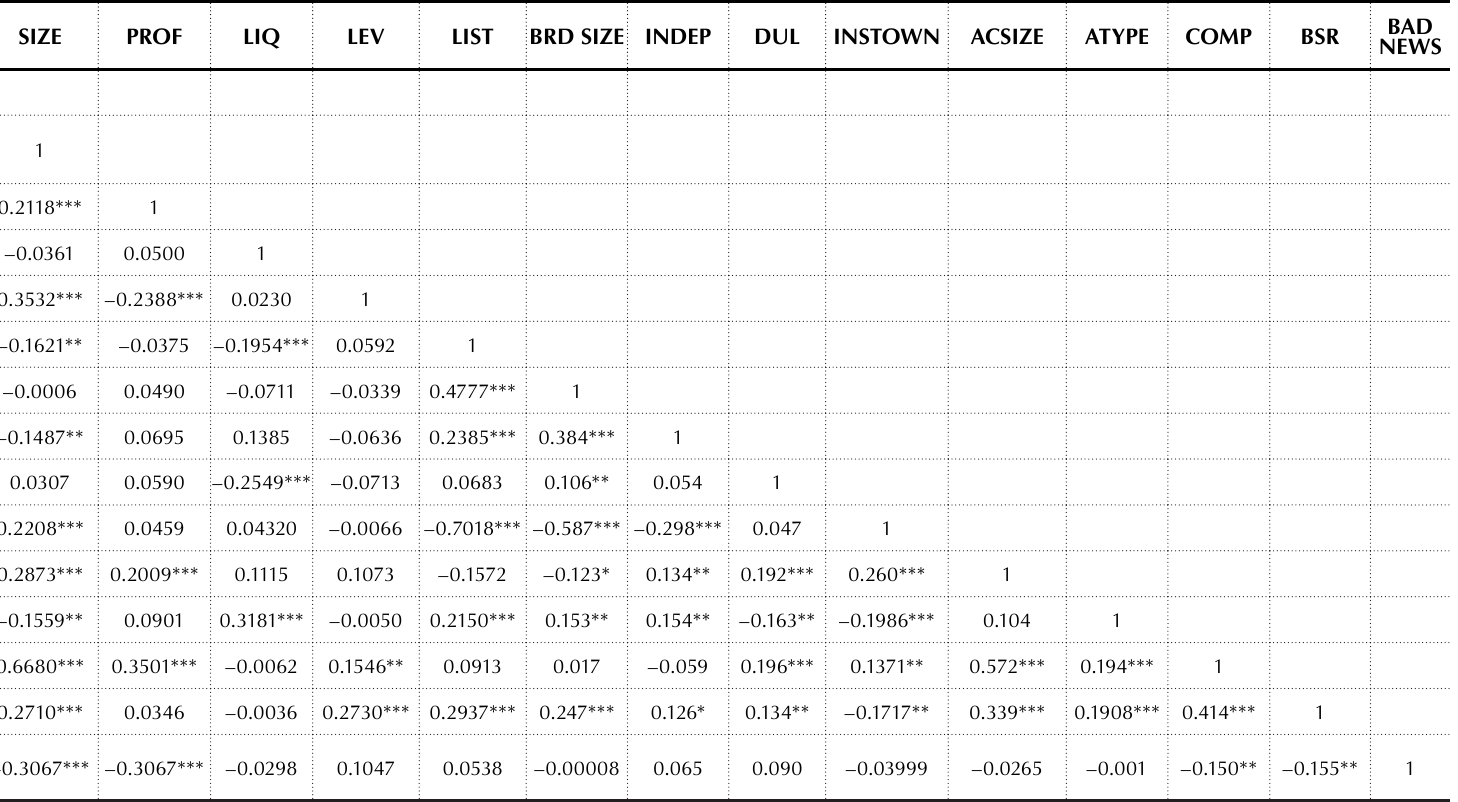
Table 6. Pearson correlation